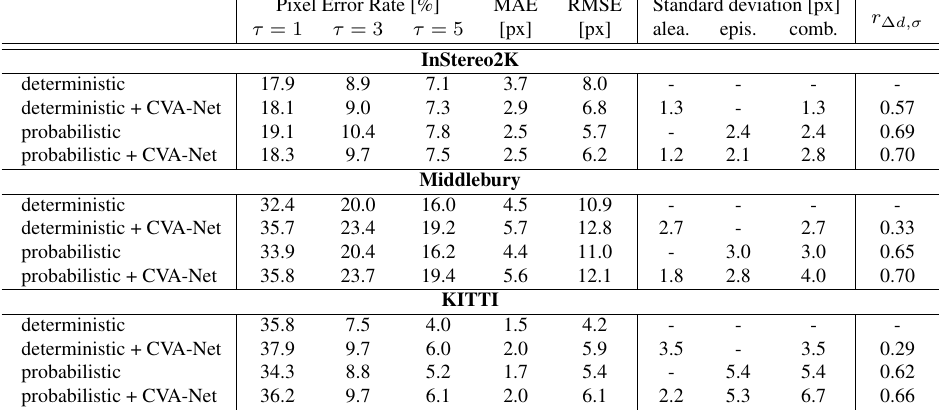
Table 1. Quantitative comparison of different variants of the method proposed. The listed variants are analysed with respect to the disparity error metrics described in Section 4.3, the average of the estimated uncertainties, whereas the combined standard deviation is computed based on Equation 13, and the Pearson correlation coefficient of the absolute disparity error and the combined estimated standard deviation. A hyphen indicates that a certain type of uncertainty is not estimated using the respective model.